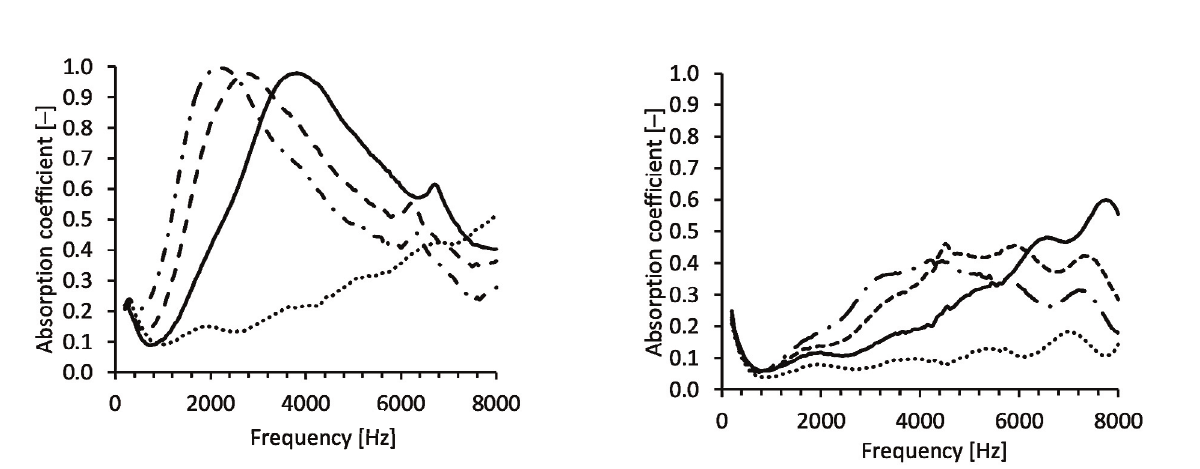
Fig. 12. Absorption coefficient for one microperforated plate (material C), distance X1 was set from 0 mm (dotted line) to 15 mm (dash-dotted line).